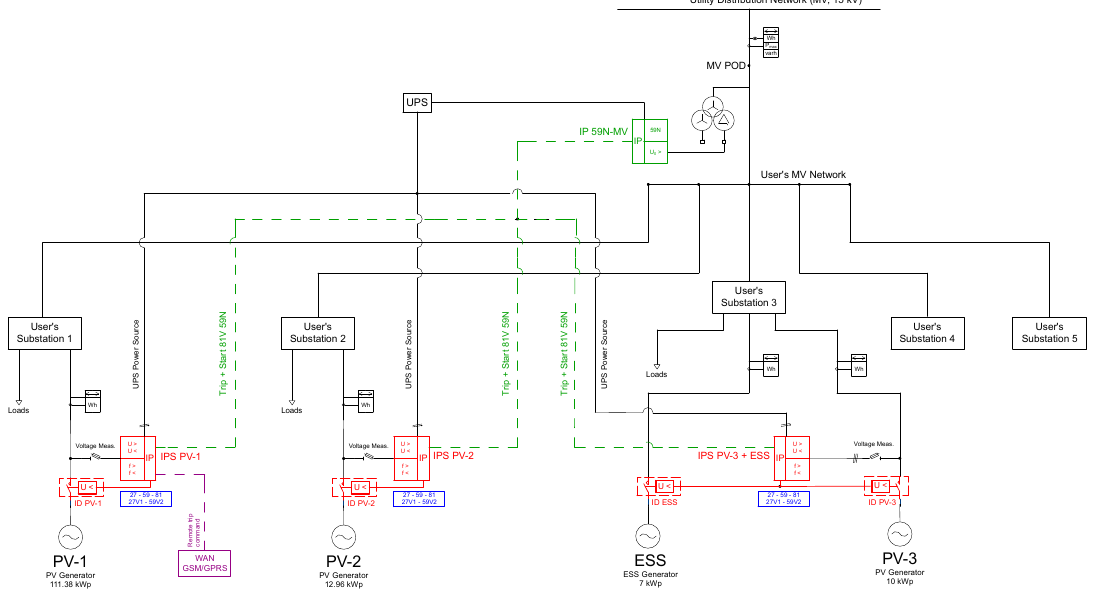
Figure 2. Schematic diagram of the electrical network of the Engineering campus of the University of Brescia. IP: Interface Protection, ID: Interface Device, POD: Point of Delivery, PV: Photovoltaic, ESS: Energy Storage System.